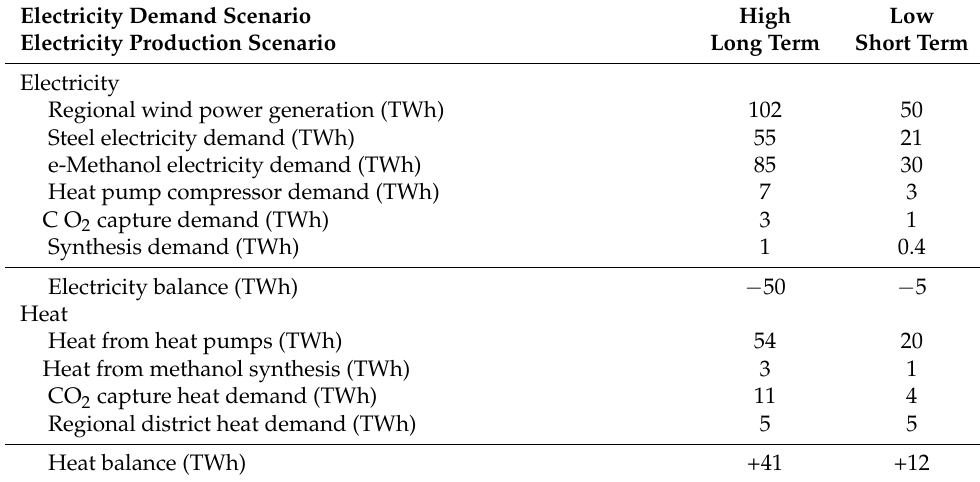
Table 2. Summary of electricity and heat balances in the Bothnian Bay area.